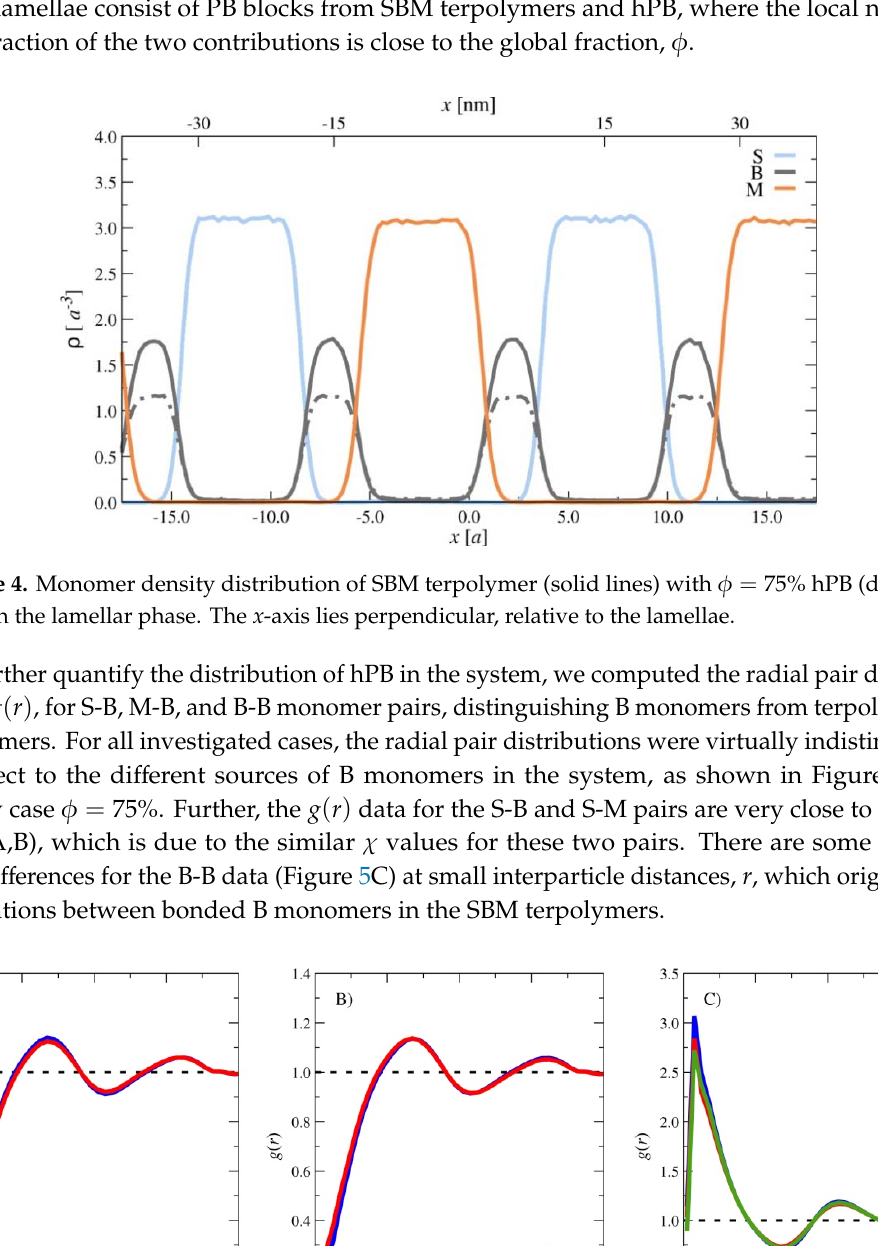
Figure 3. Morphology of the PB microphase as a function of hPB fraction. The PS and PMMA blocks form lamellae in all cases, and they have been omitted for clarity. The symbols indicate results at (cid:2038) (cid:3404) 0% , 10% , 25% , 33% , 50% , 66% , 75% , 90% , and 100% . The snapshots show typical configurations of cylinder, perforated lamella, and lamella structures at (cid:2038) (cid:3404) 0% , 33% , and 90% , respectively.